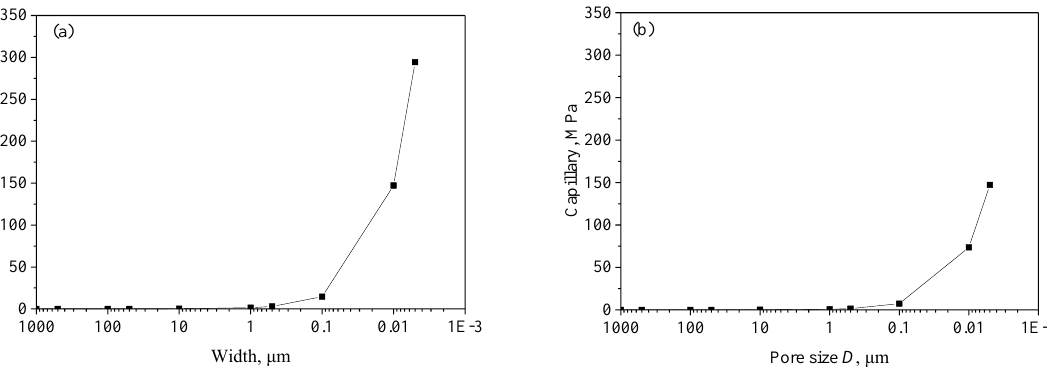
Figure 12. Capillary forces of slit-type and cylindrical pores with different sizes (( a ) refers to slit-type pore; ( b ) a cylindrical pore).